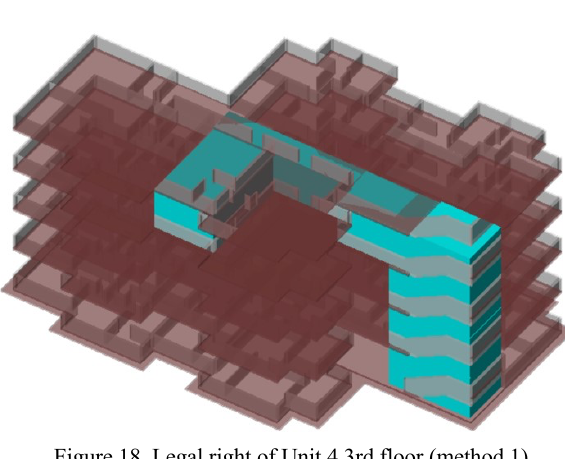
Figure 18. Legal right of Unit 4 3rd floor (method 1)